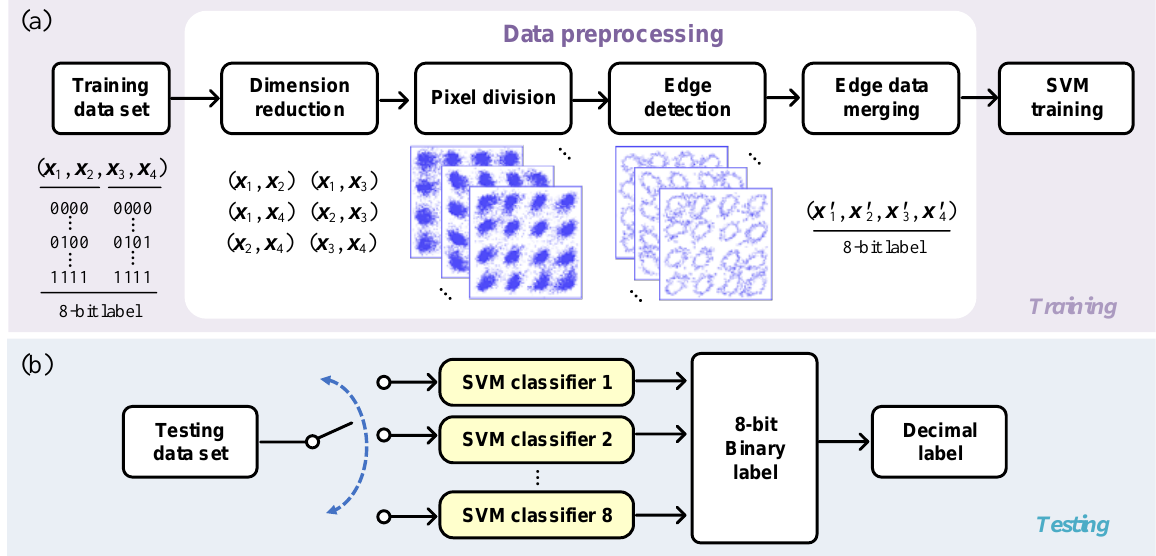
Figure 2. Schematic of SVM-based soft decision. ( a ) SVM training phase with data preprocessing. ( b ) SVM testing phase.